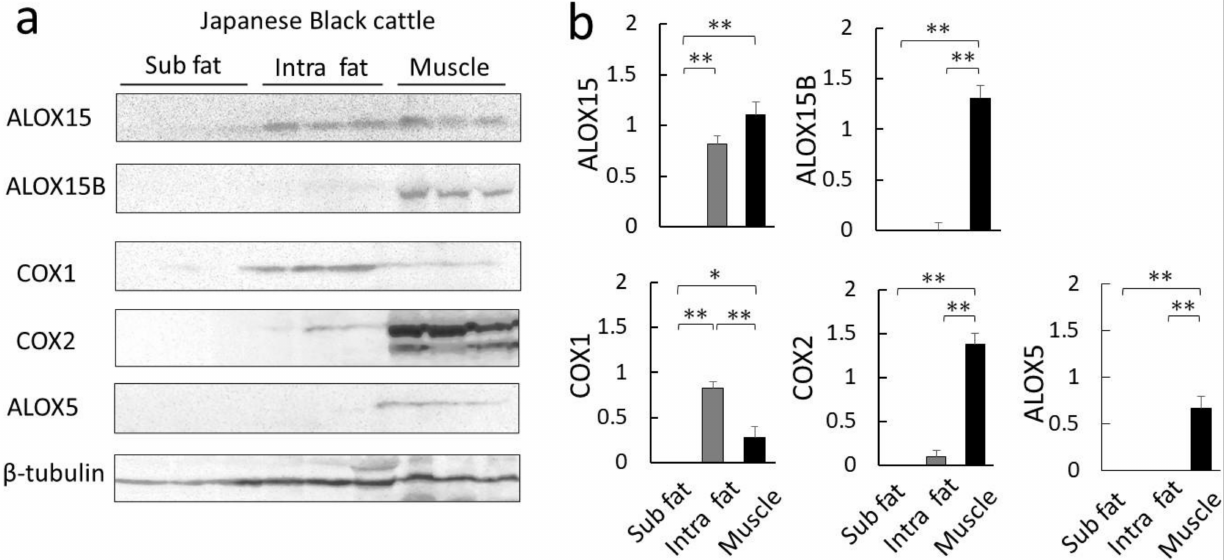
Figure 5. Comparison of lipid oxidase expression in Japanese Black cattle. ( a ) Western blot analysis using specific antibodies against lipoxygenase or cyclooxygenase was used to detect protein levels in subcutaneous fat (Sub fat), intramuscular fat (Int fat), and muscle tissue. The samples consisted of total proteins prepared from the sternocleidomastoid muscle of Japanese Black cattle. Samples prepared from three different cattle were analyzed. ( b ) The graph shows the mean of the intensity values detected by Western blot analysis. The data represent the mean ± standard error ( n = 3). Significant differences are shown as follows: * p < 0.05 and ** p < 0.01 (Tukey’s test; Sub fat vs. Int fat vs. muscle tissue for each protein). Abbreviations: arachidonic acid 15-lipoxygenase (ALOX15), its isozyme ALOX15B, 5-lipoxygenase (ALOX5), cyclooxygenases 1 (COX1), and its isozyme